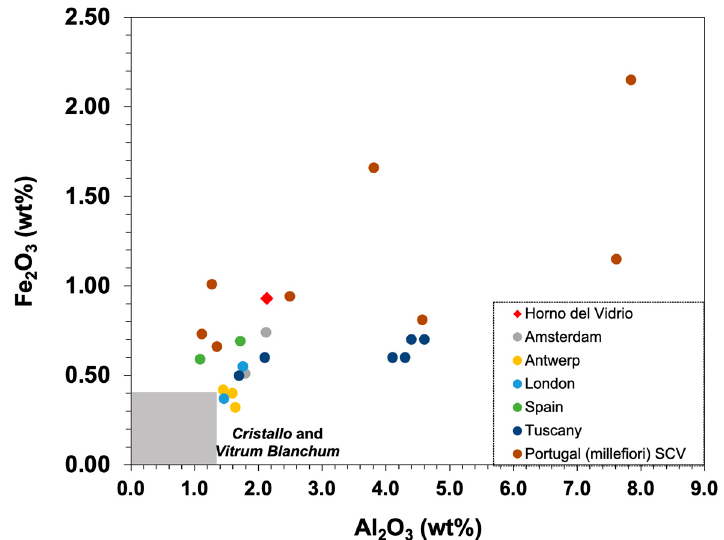
Figure 6. Binary chart of alumina versus iron oxide in weight percent of oxides. The grey shadow represents the values for genuine Venetian cristallo and vitrum blanchum . Samples from Amsterdam, Antwerp, London, Spain and Tuscany belong to façon-de-Venise glass that was locally produced and, finally, the Portuguese samples belong exclusively to millefiori fragments unearthed in the Santa Clara-a-Velha Monastery in